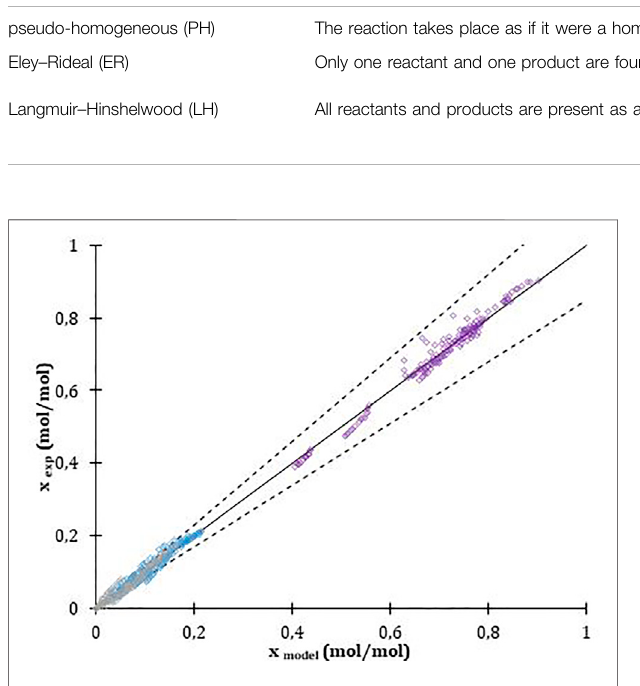
FIGURE 8 | Parity diagram for esteri fi cation of GA with butanol and Na fi on NR ® as catalyst.